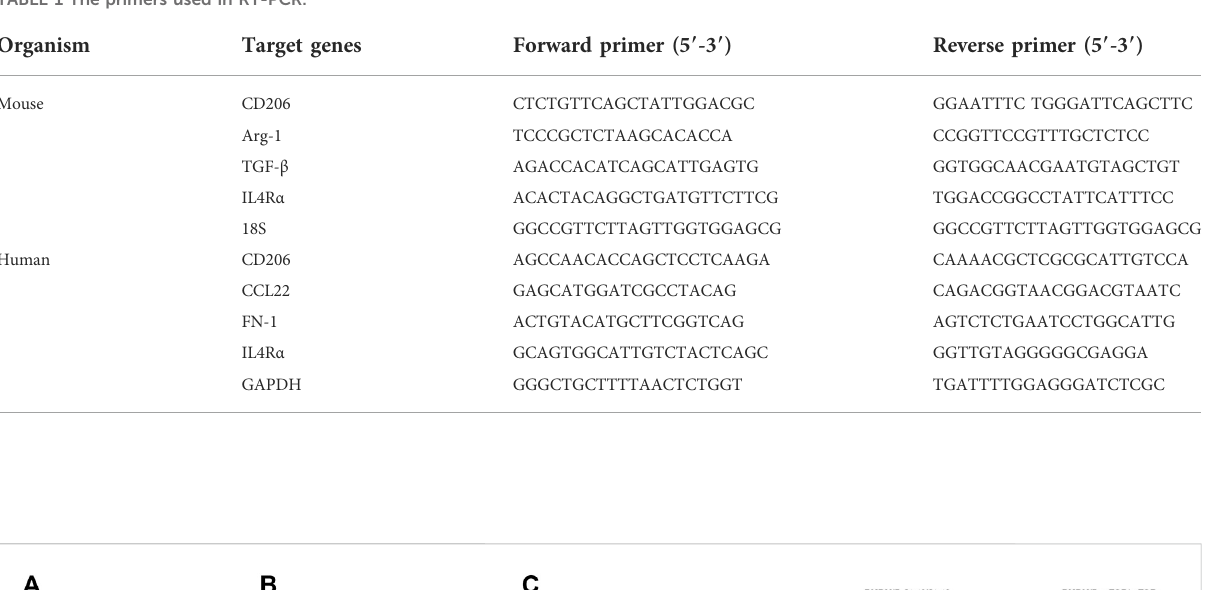
TABLE 1 The primers used in RT-PCR.